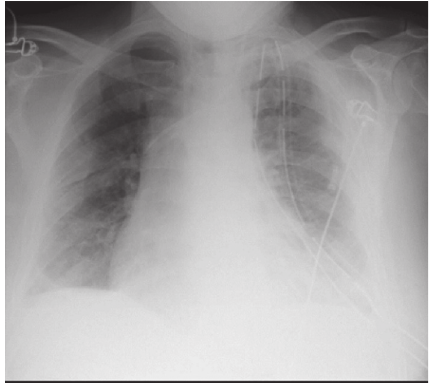
Figure 3: Immediate postoperative CXR.